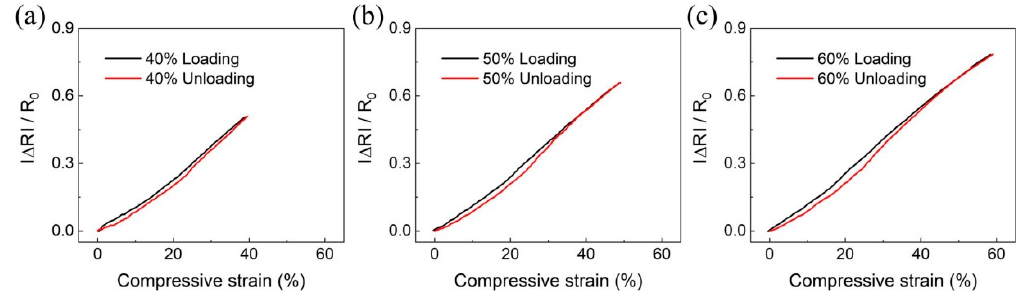
Figure 6. The relative resistance changes according to compressive strain with ( a ) 40%, ( b ) 50%, and ( c ) 60%. Black lines show changes in resistance when loading, and red lines show changes in resistance when unloading.